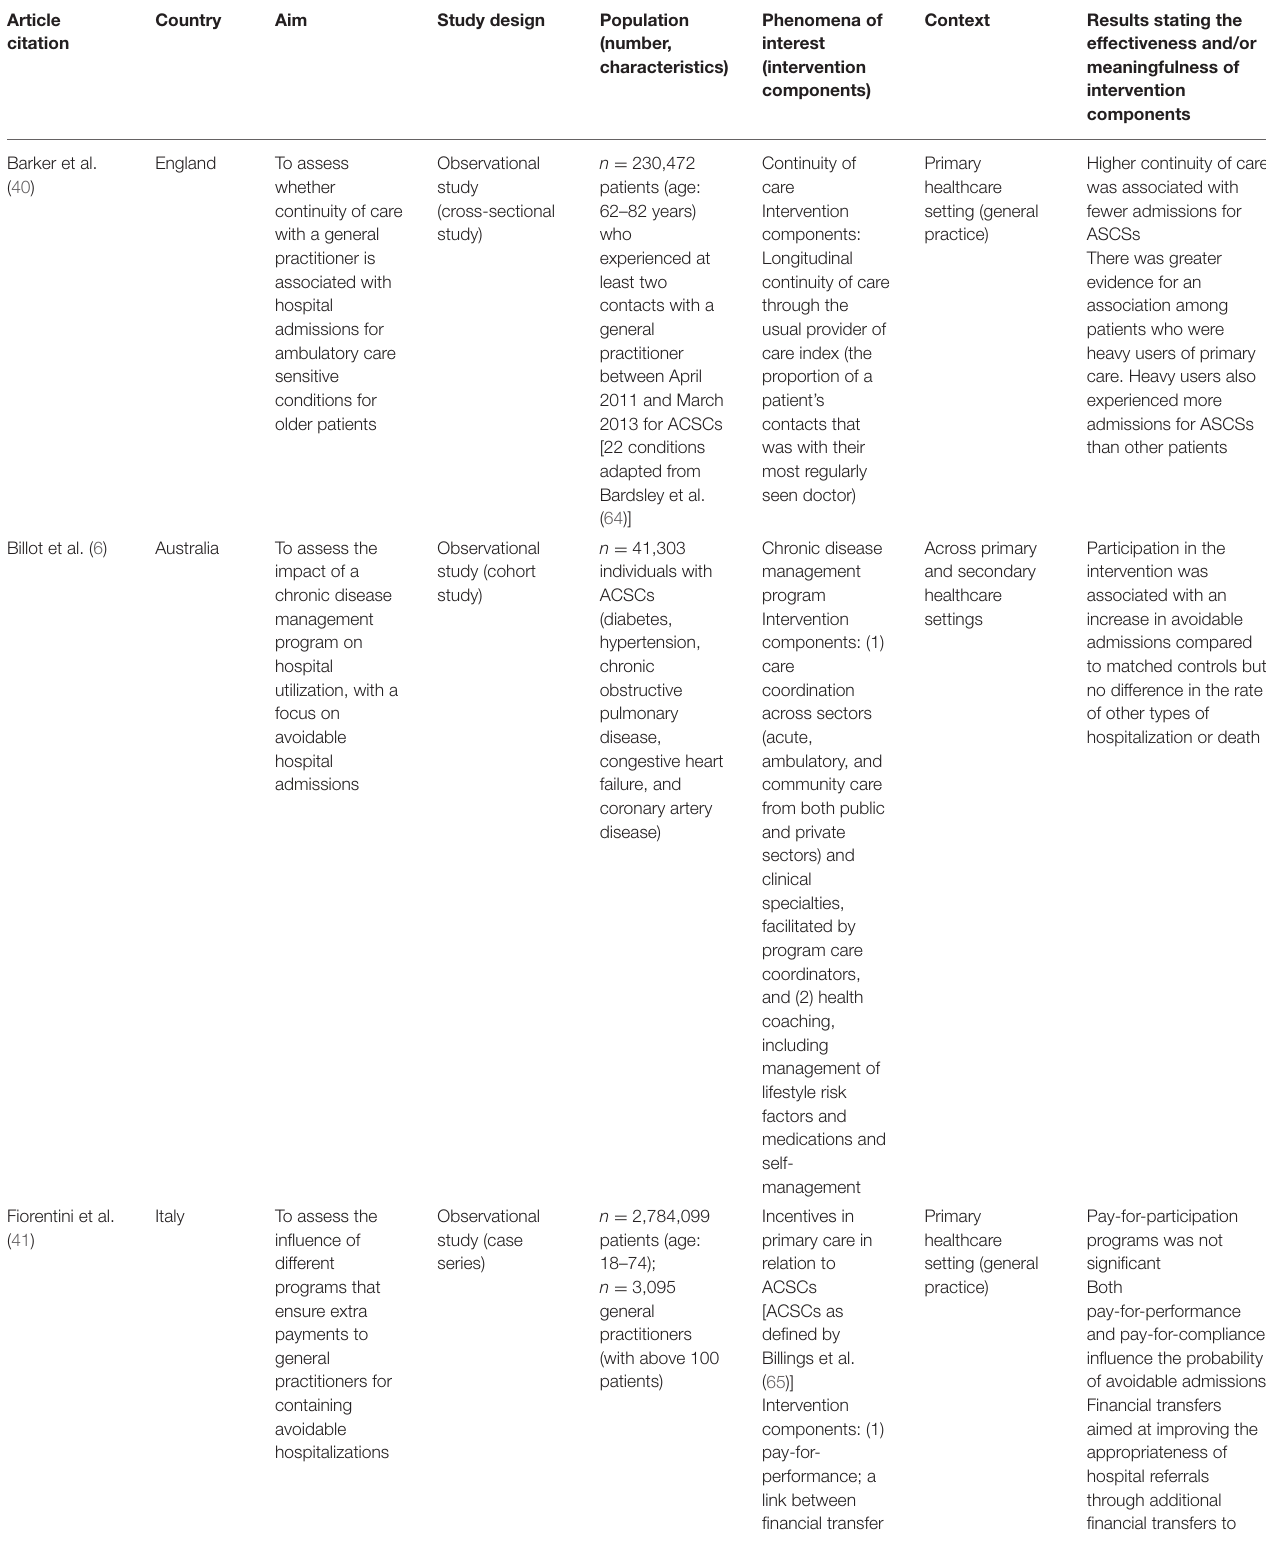
TABLE 2 | Main characteristics of included